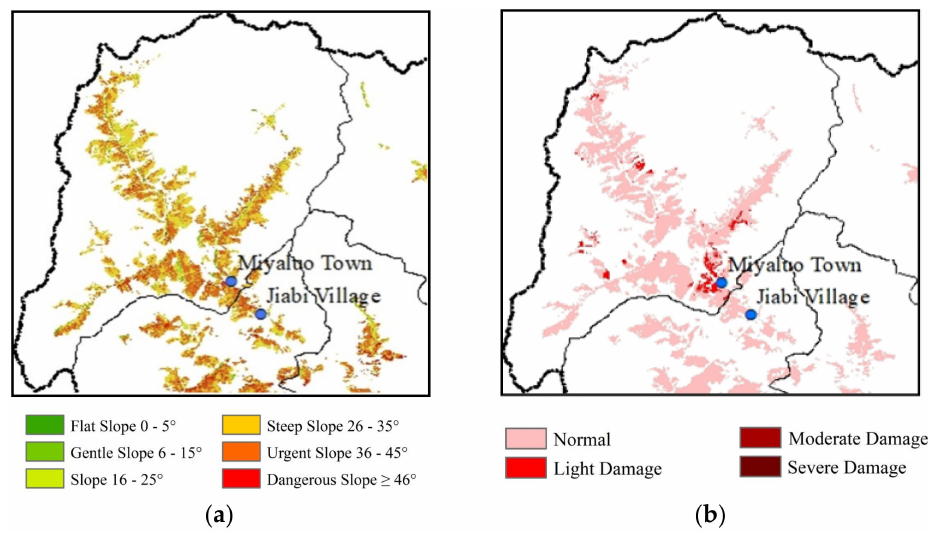
Figure 11. The relationship between slope and Lophodermium piceae : ( a ) the slope distribution of Miyaluo Town; ( b ) the disease-investigation results of Miyaluo Town.